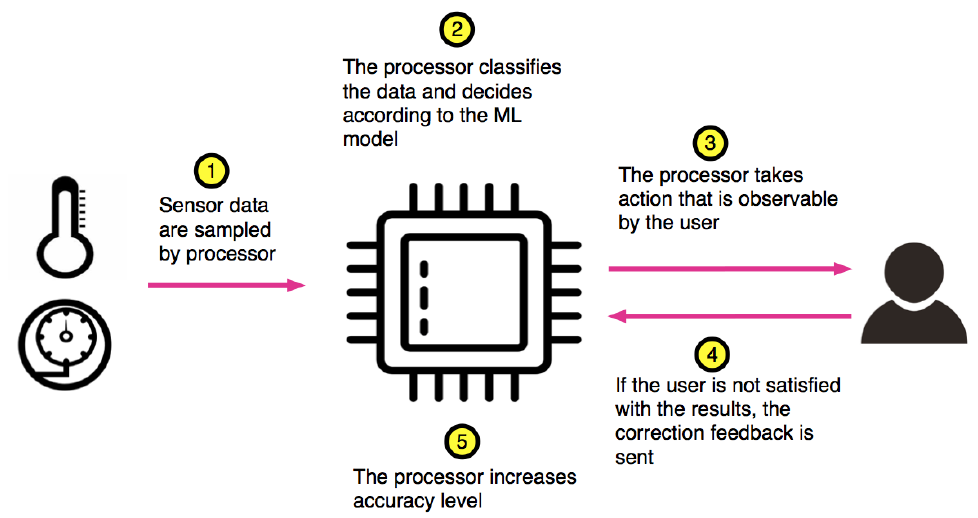
Figure 1. Precision control proposed in our Approximate IoT processor.